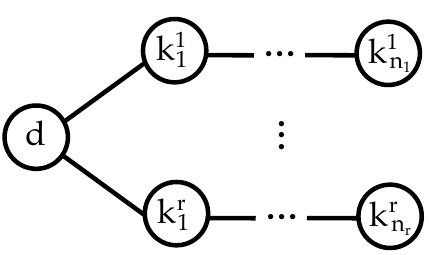
Figure 2 . Plumbing graph for Seifert manifolds with r special (cid:12)bers. For r = 3 this graph corresponds to the Seifert quivers in the text. We consider here g = 0 for the central node. This also gives the quiver for the theory b T [(cid:10) ; G ]. [ d ;0 ; [ k i 1 ; (cid:1)(cid:1)(cid:1) ;k i ni ]]